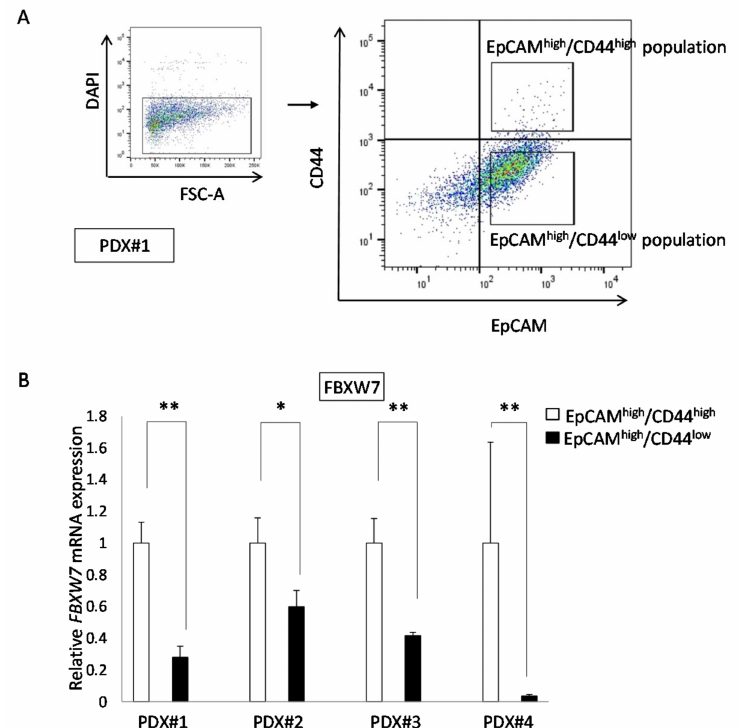
Figure 3. Analysis of human CRC PDXs. ( A ) Representative flow cytometric